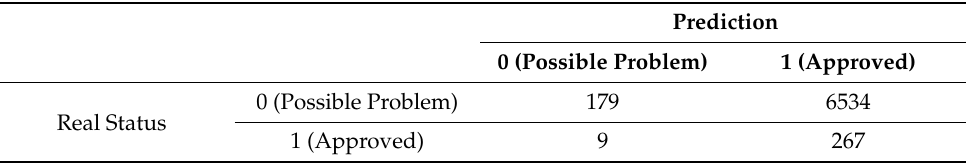
Table 8. Confusion matrix of model not using gender and social welfare program